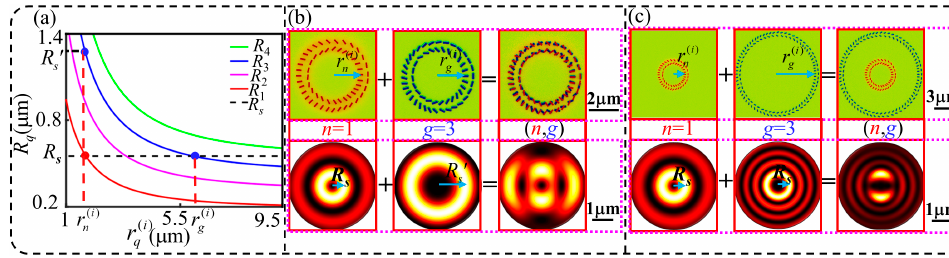
Figure 2. ( a ) The variation of the doughnut radius R q for the VBs of orders 1 to 4 versus the radius ( ) i r of the slit-pair ring. Superposition of VBs of the orders 1 and 3 ( b ) by two slit-pair rings of equal radius but with unequal radii of the formed doughnuts and ( c ) by two slit-pair rings of modulated radius with equal radii of doughnuts.